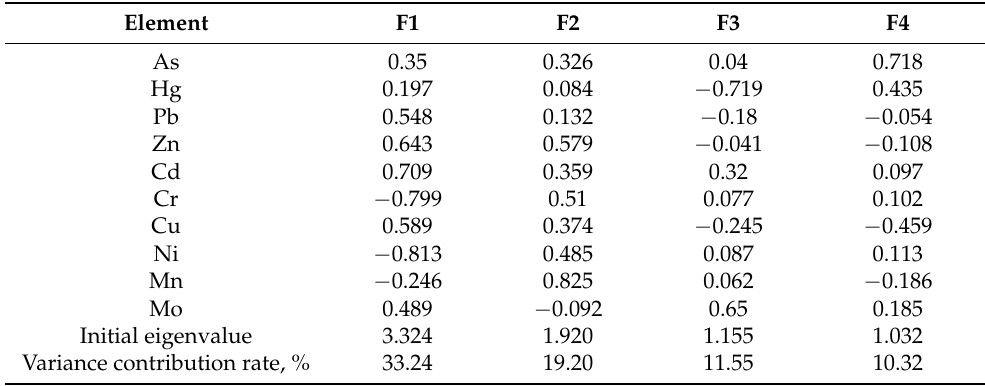
Table 5. Principal component analysis